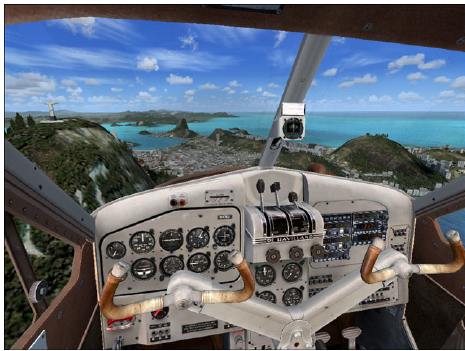
Fig. 5. Visualization of the Rio de Janeiro area in Microsoft Flight Simulator X (source: